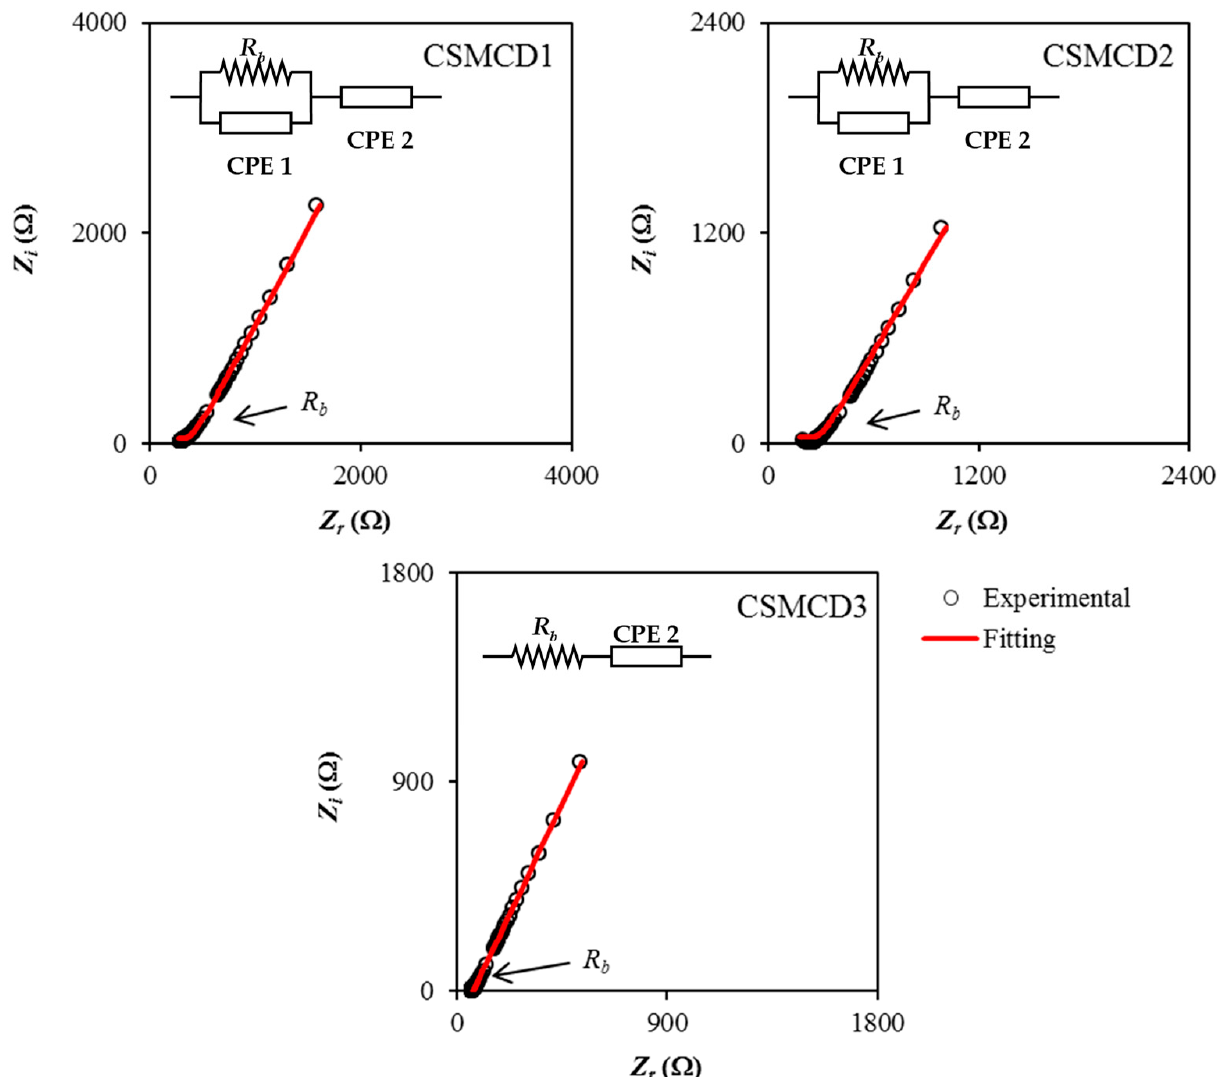
Figure 1. Impedance plots for the electrolytes.